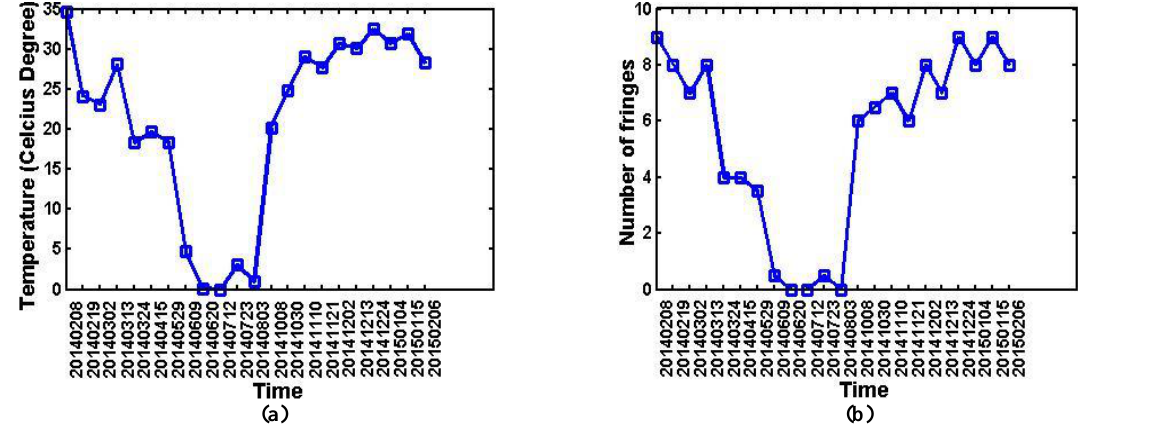
Figure 4. (a) Variation in temperature with time. (b) Variation in observed number of fringes with time in SpotLight images The correlation between the number of fringes observed over the bridge and the difference in temperature is 96.77% for our X-band interferograms over the LU bridge (Fig. 5).